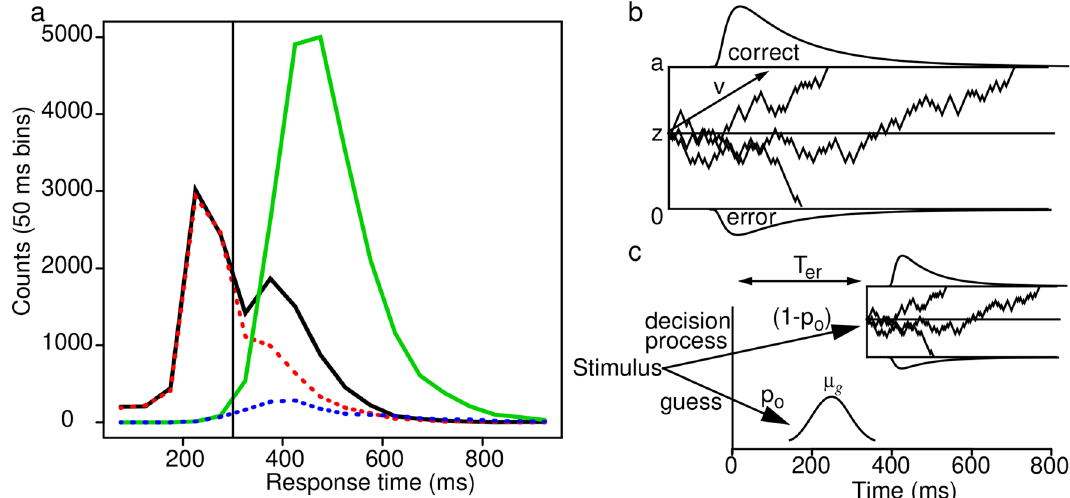
Figure 1. ( a ) The black solid line and red dashed line show distributions of RTs collapsed over conditions with the lowest accuracy. These combined the 5 stimulus contrast conditions with the highest speed-stress plus the lowest stimulus contrast condition with the second to highest speed-stress. The black solid line is for correct responses and the red dashed line is for errors. The green solid line and blue dotted line show distributions for the conditions with highest accuracy. These are the three stimulus contrast conditions with highest discriminability for the slowest speed-accuracy condition and the two conditions with the highest discriminability for the second slowest condition. The green solid line is for correct responses and the blue dotted line is for errors. The vertical line is at 300 ms and the parts of the RT distributions below it completely overlap with chance accuracy. The distributions in ( a ) are wider than would be representative of any individual because all responses from all subjects are included in the analysis (Fig. 3 shows narrower distributions for individual subjects, see the discussion in Ratcliff 12 , p. 454). ( b ) An illustration of the diffusion model. ( c )